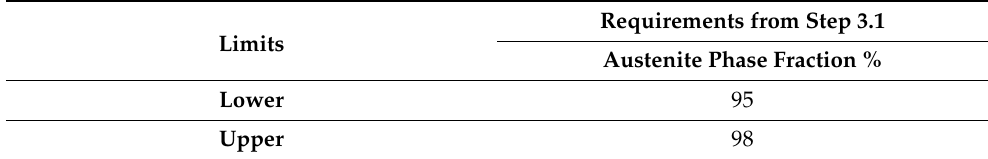
Table 13. Austenite Phase Fraction